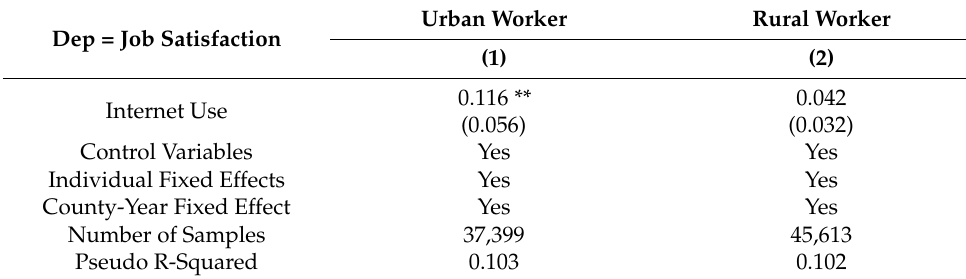
Table 3. Urban and Rural Heterogeneity.